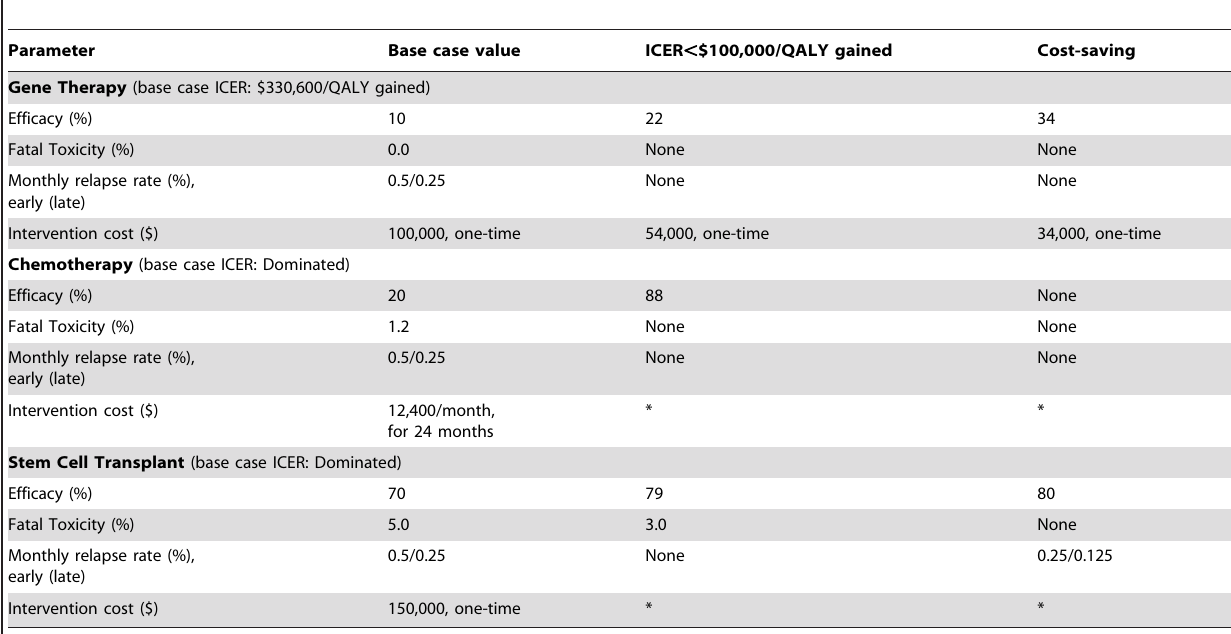
Table 3. Threshold which key parameters would need to reach for each type of HIV cure strategy to be cost-effective (ICER , $100,000/QALY gained) or cost-saving.